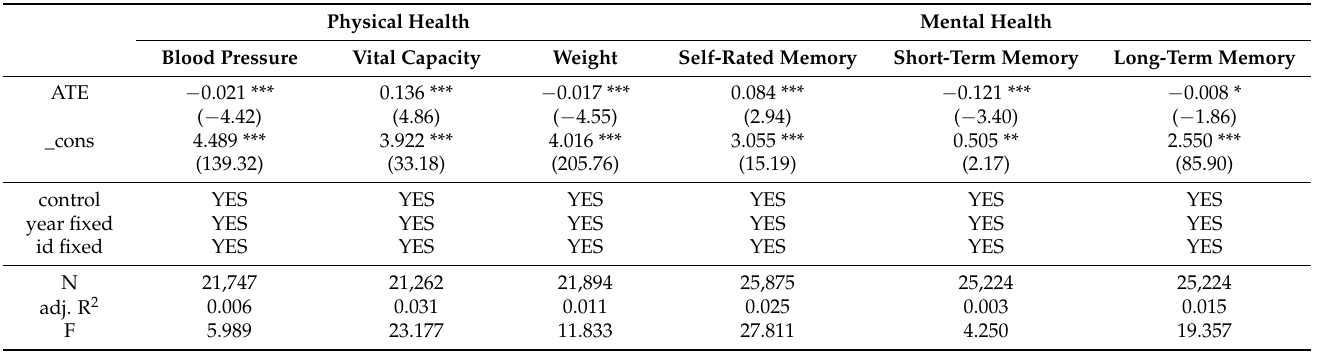
Table 5. Propensity-score-matching